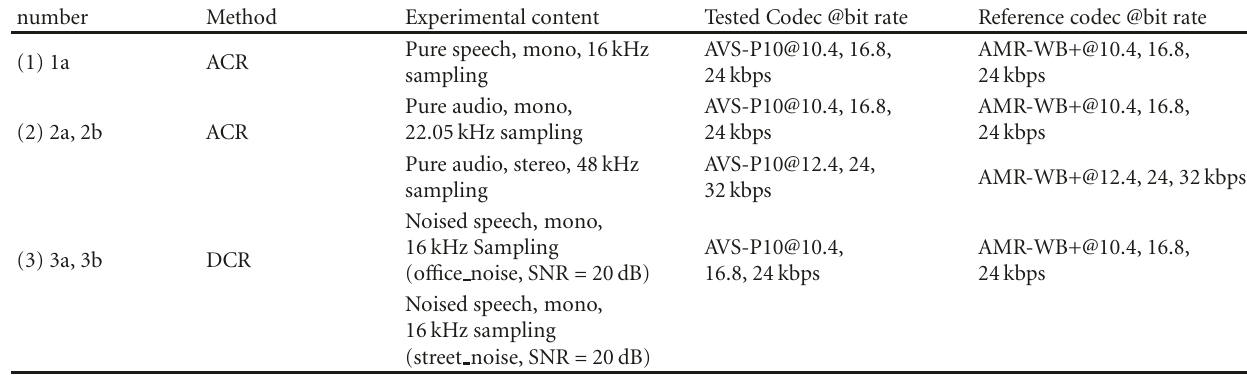
Table 8: Basic testing information.